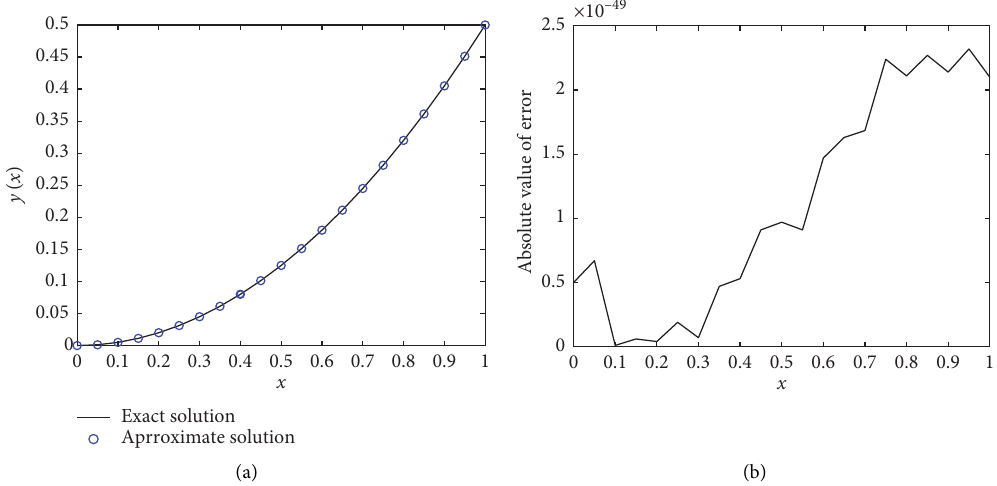
Figure 2: Plot of the exact solution along with the approximate solution (a) and absolute value of error (b) for Example 3. Table 4: Comparison of the absolute error for Example 3. Our